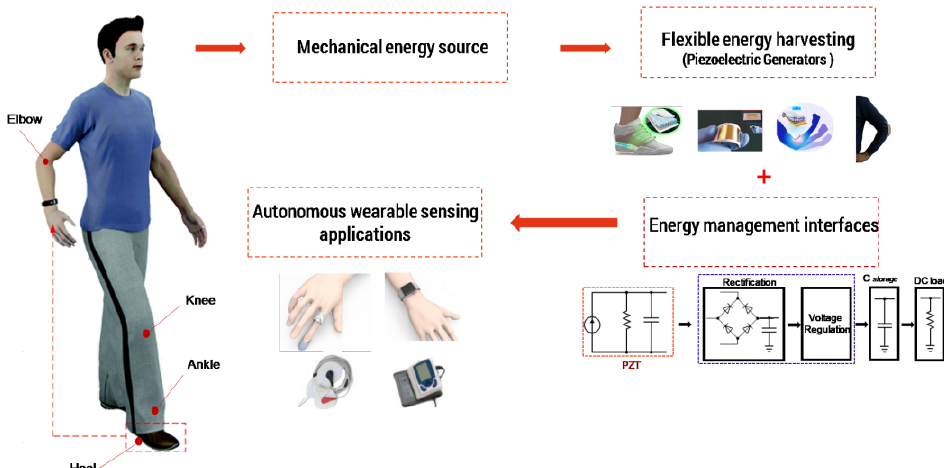
Figure 6. Energy harvesting for autonomous wearable